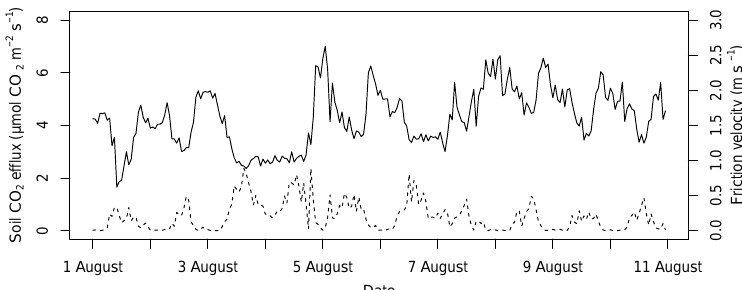
Figure 1. Example of mean hourly soil CO 2 effluxes from the eight automated chambers (solid line) and mean hourly friction velocity ( u ∗ ) at 43m above the soil surface (dashed line) for 10 days during August 2015.